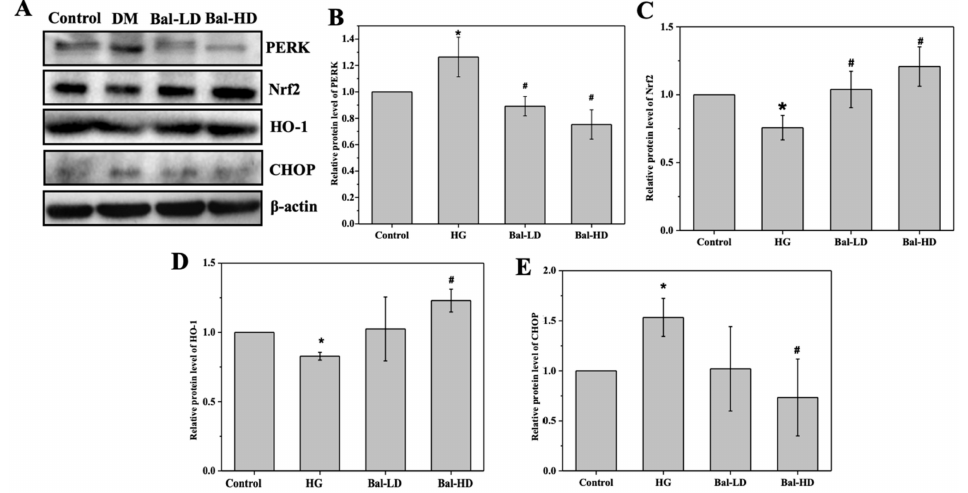
Figure 6. The e ff ect of baicalein on the level of PERK, Nrf2, HO-1, and CHOP in HL-7702 cells. HL-7702 cells were incubated with 60.5 mM of glucose and baicalein (5 µ M and 20 µ M) for 24 h. The levels of target protein were determined by immunoblotting. ( A ) Representative immunoblots of the proteins including PERK, Nrf2, HO-1, and CHOP. ( B – E ) Quantitative analysis and statistical analysis of the level of PERK, Nrf2, HO-1, and CHOP relative to the control group, respectively. The data are represented as the mean ± SD ( n = 3). * p < 0.05 vs. control group; # p < 0.05 vs. HG